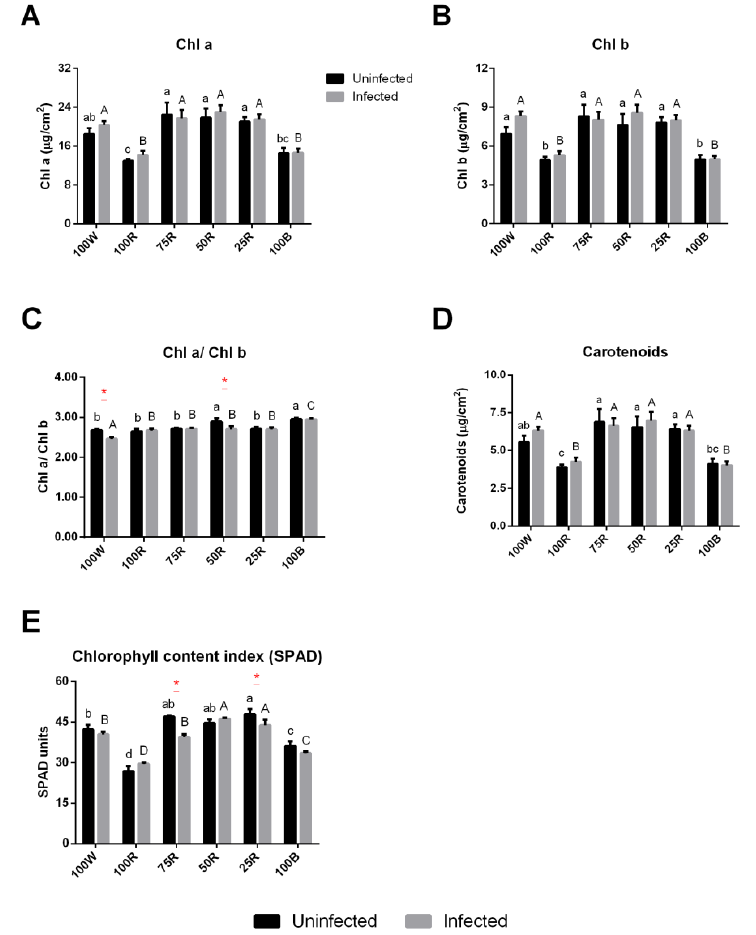
Figure 3. Effect of light quality on pigment content. Chlorophyll a ( A ) and b ( B ) (Chl a and Chl b) (mg cm − 2 ); chlorophyll ratio a/b (Chl a/Chl b) ( C ); carotenoids (mg cm − 2 ) ( D ); chlorophyll content index (SPAD) ( E ). The values are presented as the mean of at least 3 biological replicates ± SE. Low- ercase letters represent multiple comparisons of uninfected groups, capital letters are multiple com- parisons of infected groups and asterisks are comparisons of uninfected and infected groups in the same light treatment. Mean values with the same letter or without asterisk are not significantly dif- ferent (Fisher LSD, p < 0.05).